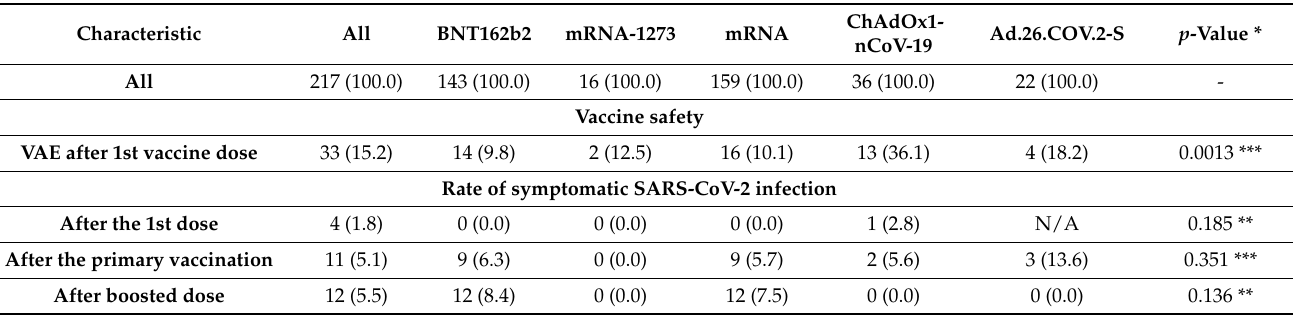
Table 2. Safety and rate of symptomatic SARS-CoV-2 infection data for HIV-positive individuals vaccinated against COVID-19 stratified by the type of first vaccination dose. Presented as number and column